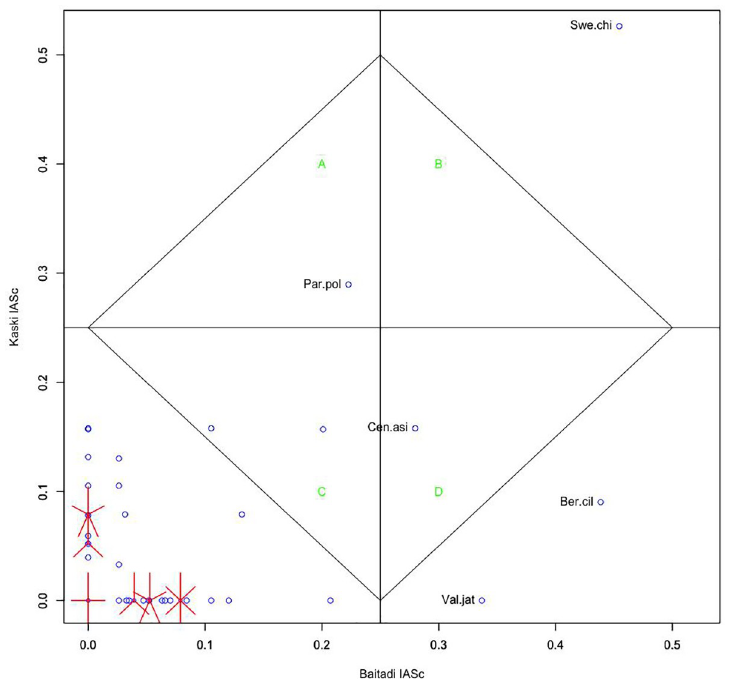
Fig 2. Cultural consensus matrix of two groups (participants from Panchase, Kaski and Sigas, Baitadi).